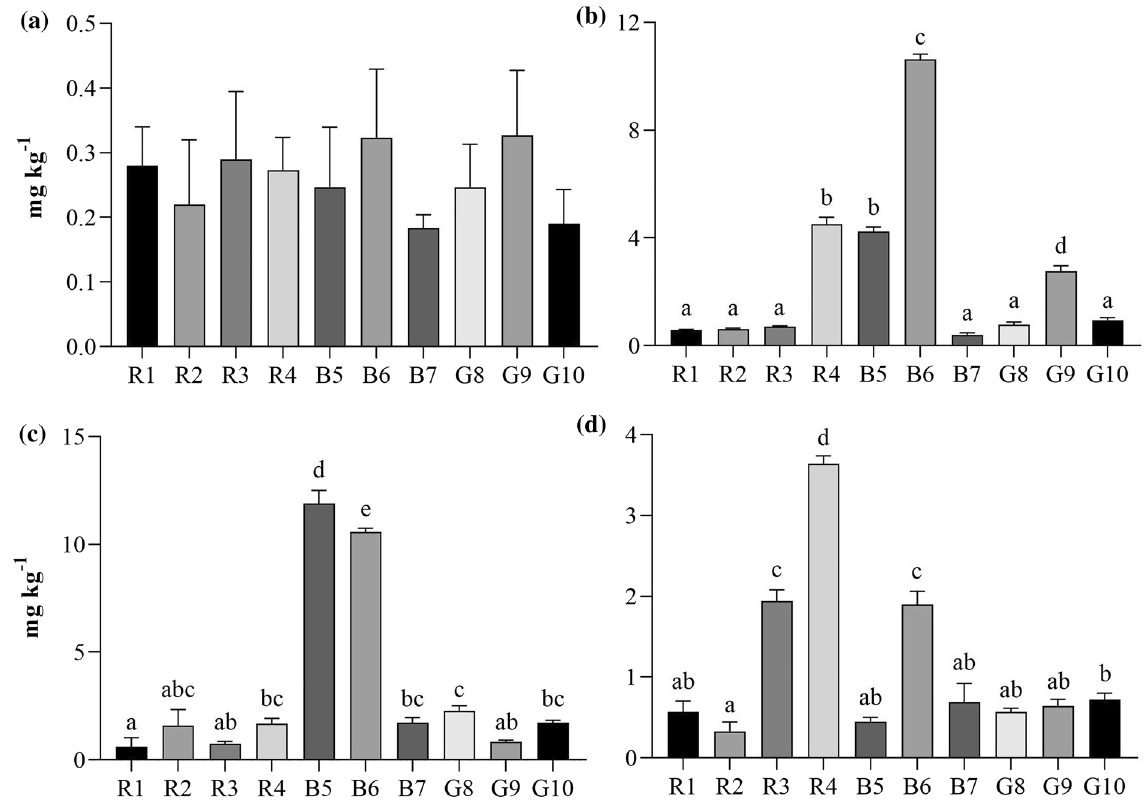
Figure 2. Mean concentration of ( a ) Co, ( b ) Pb, ( c ) As, and ( d ) Cr in the 10 algae species evaluated. Error bars indicate standard deviation. Letters indicate significant